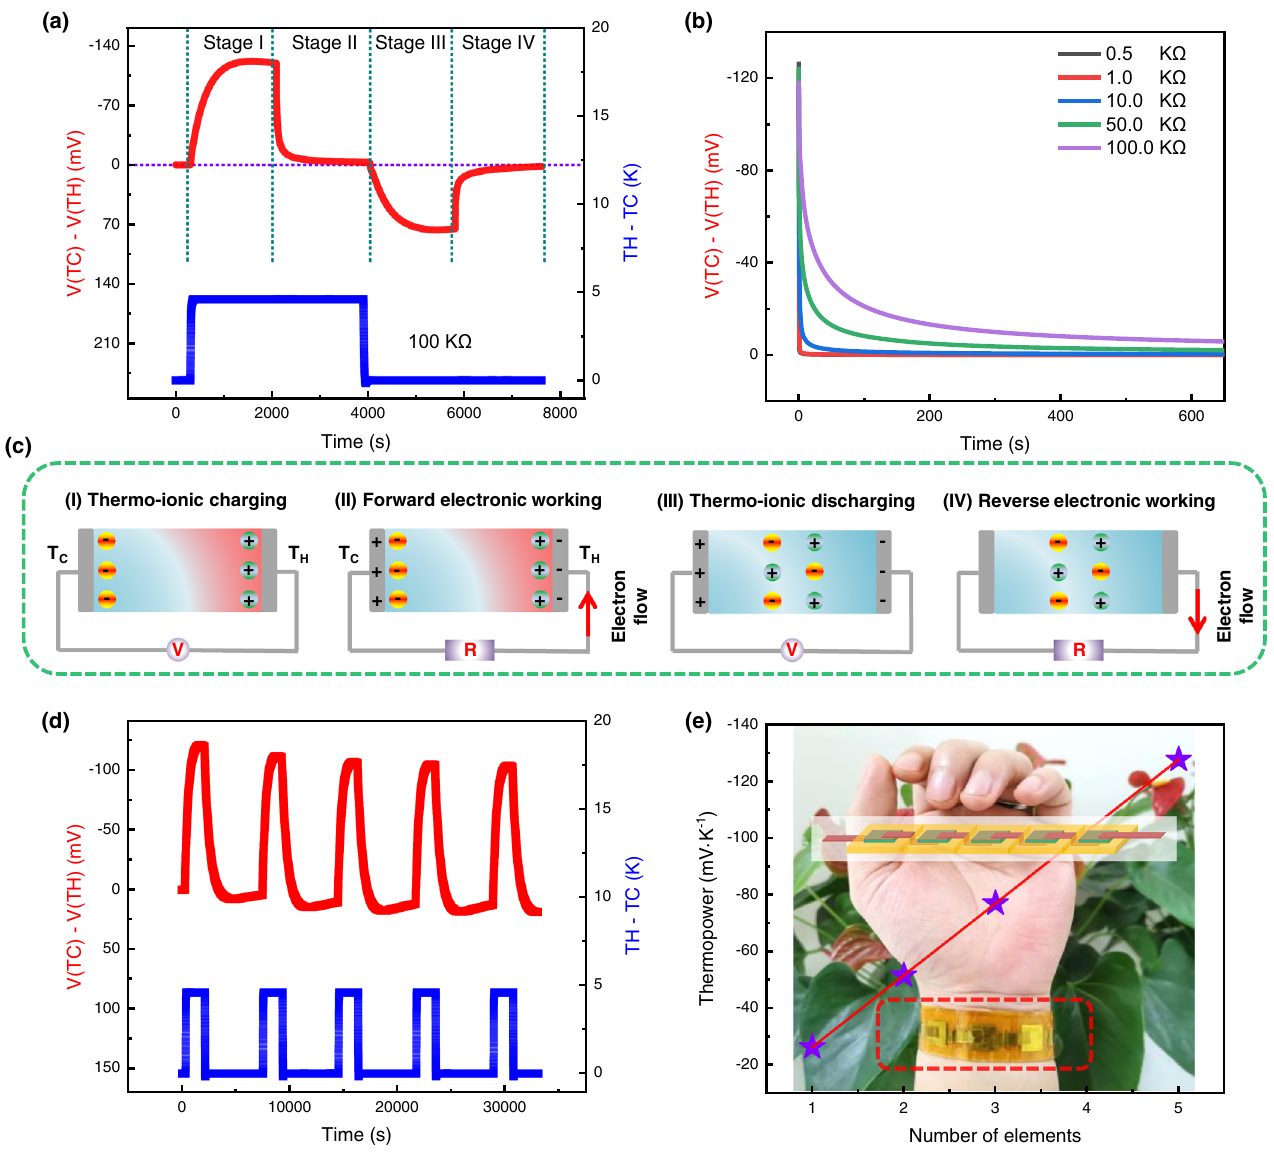
Fig. 5 Thermoelectric properties of PVA-cellulosic membranes. a The typically full thermo-ionic charging and electronic discharging cycle curve of PVA-cellulosic membrane in fi ltrated with 0.8 mol/L CuCl 2 -PEO aqueous solution. b Voltage decay curves on the external load with different resistances connected to the i-TE during stage II. c Illustration of the working principles for ionic thermoelectric devices. d Output voltage of the PVA-cellulosic membrane under 5 repeated heating-cooling cycles at the temperature difference of 4.6 K. e The improved thermopower of modular i-TE device. Photo credit: Bin Chen, Department of Electrical and Electronic Engineering, Southern University of Science and